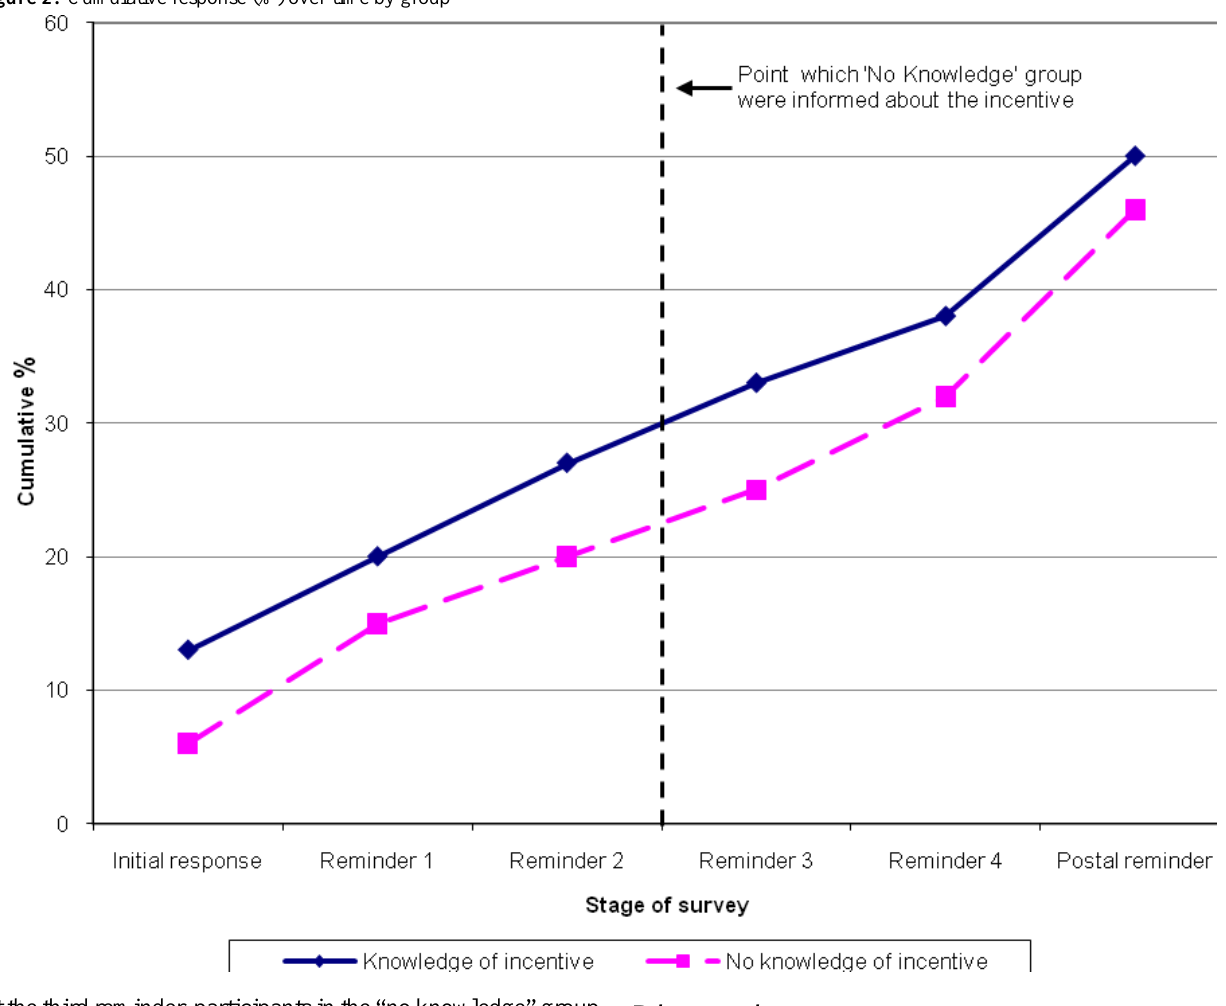
Figure 2. Cumulative response (%) over time by